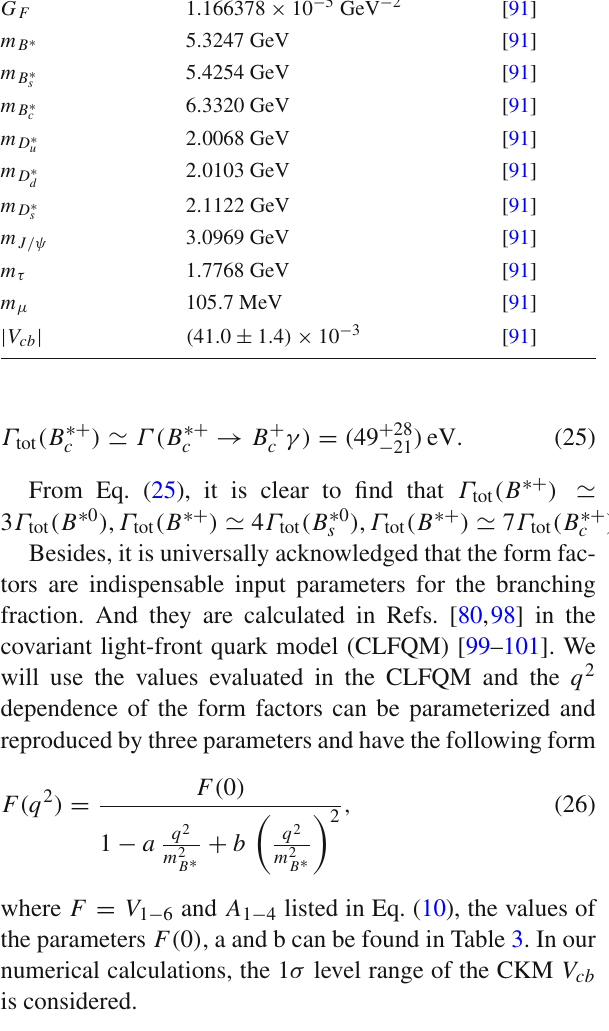
Table 2 Input parameters used in our numerical analyses